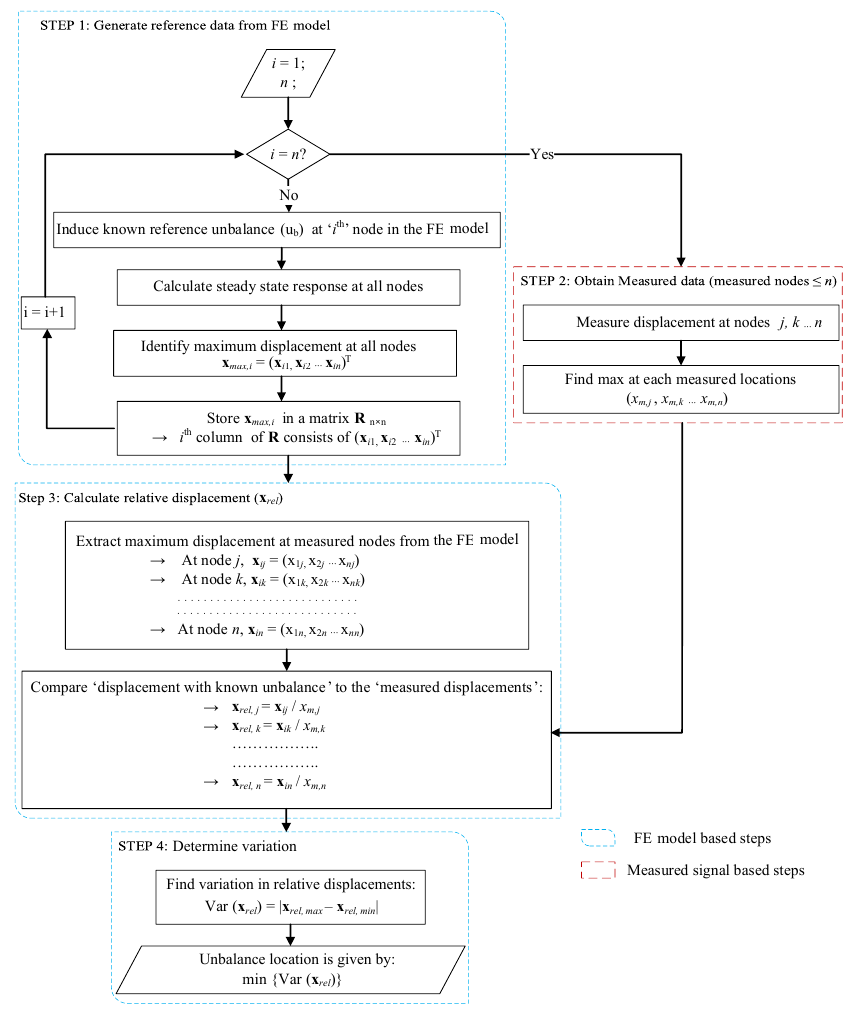
Figure 1. Process flow for unbalance detection using two measured